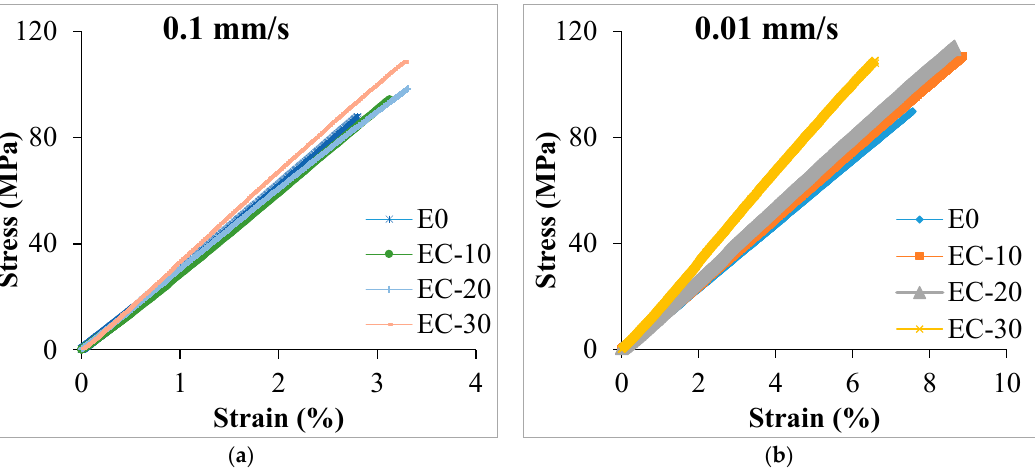
Figure 5. Characteristic stress–strain curves of all the composites at strain rates of ( a ) 0.1 mm/s and ( b ) 0.01 mm/s.